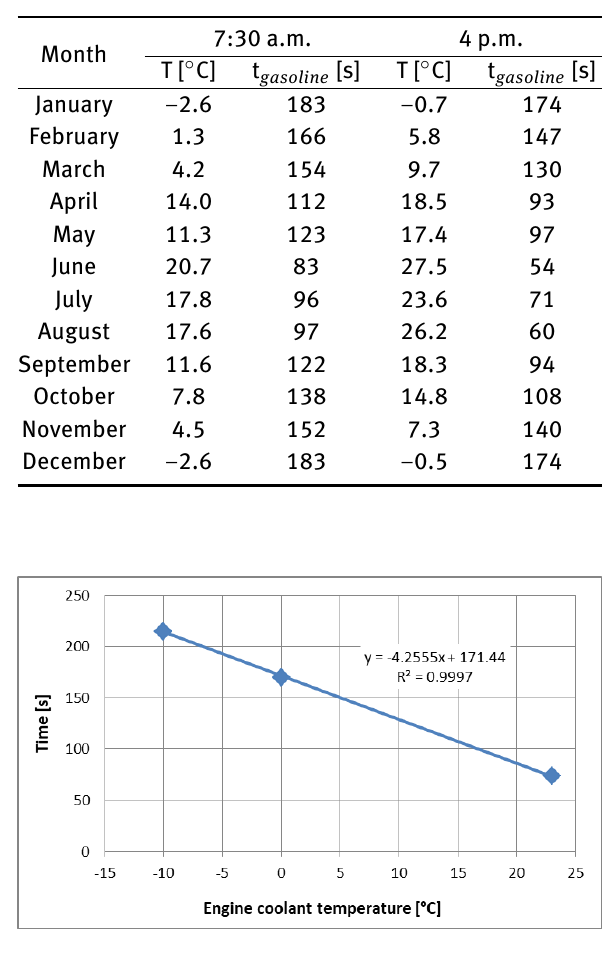
Figure 7: Engine operation time in the phase of its fueling with gasoline as a function of the engine’s initial temperature.